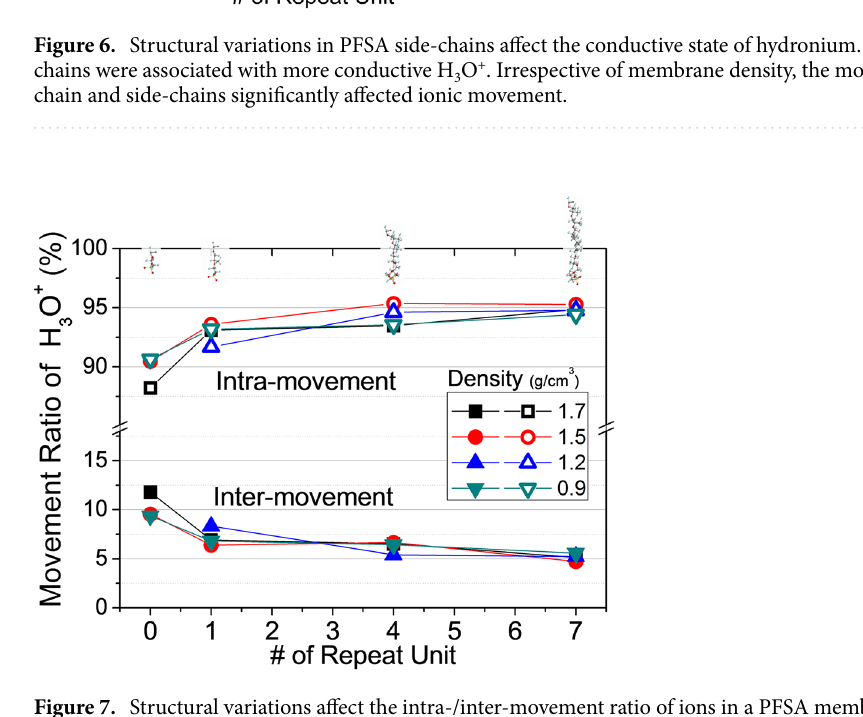
Figure 7. Structural variations affect the intra-/inter-movement ratio of ions in a PFSA membrane. H 3 O + intra- movement increases with increasing side-chain length, because this fundamentally affects both the surface area and free volume associated with chain